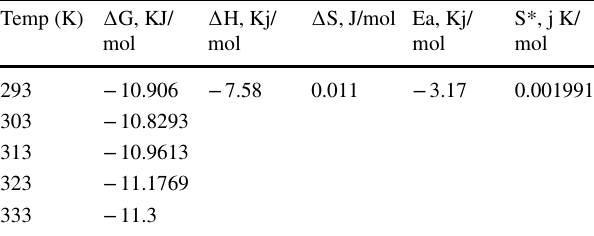
Table 4 Thermodynamic parameters for biosorption of Ni(II)